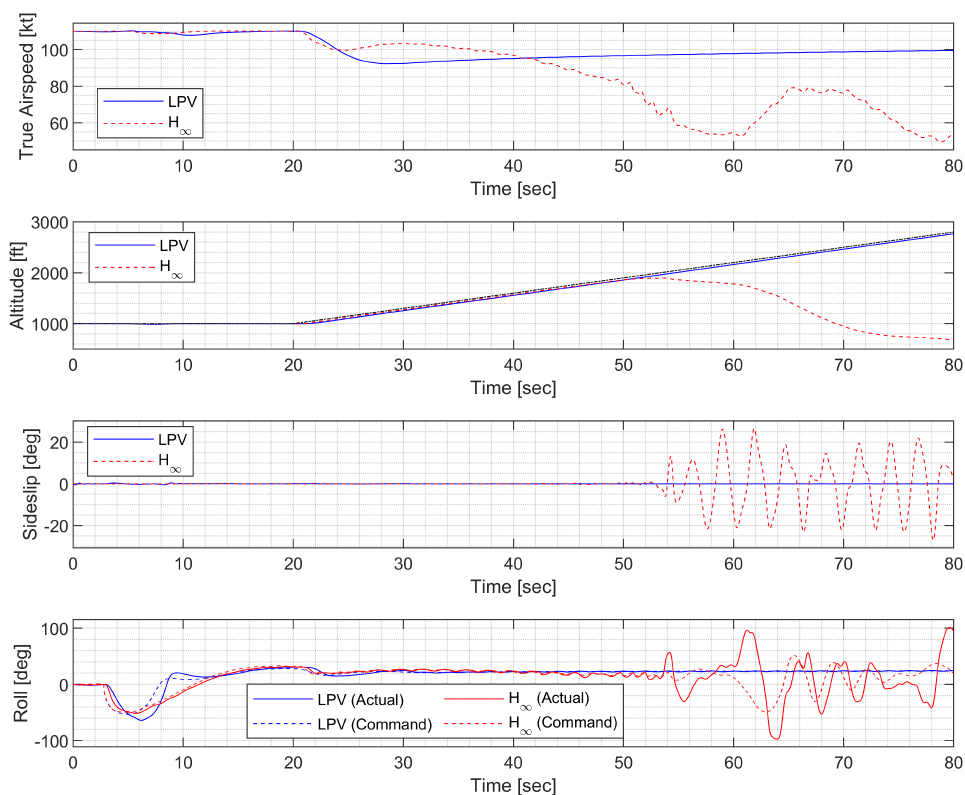
Figure 27. State history of the helical